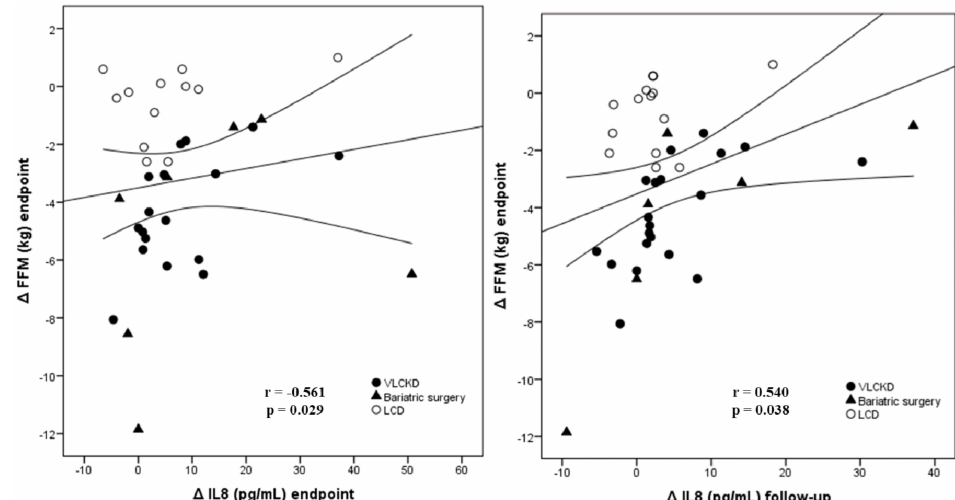
Figure 4. Scatterplot representing the association between weight loss treatment-induced di ff erences from baseline ( ∆ ) at endpoint (2–3 months) in fat-free mass (FFM) and di ff erences in circulating levels of interleukine-8 (IL-8) at endpoint and at follow-up (6 months). In the plots each point refers individual changes. The center line represents the linear regression trendline. The lines above and below the center line represent the upper and lower bounds of the 95% confidence interval around the trendline.